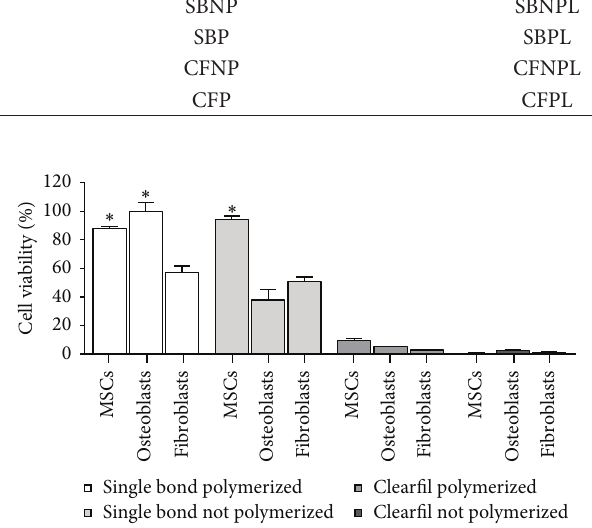
Figure 2: Graphic representation of the cell viability of all cell lineages (MSCs, fibroblasts, and osteoblastic-like cells) in response to substances leached from the dental adhesives: Adper Single Bond 2 and Clearfil SE Bond, whether or not polymerized. ∗ Significantly higher than all other groups ( 𝑃 < 0.05